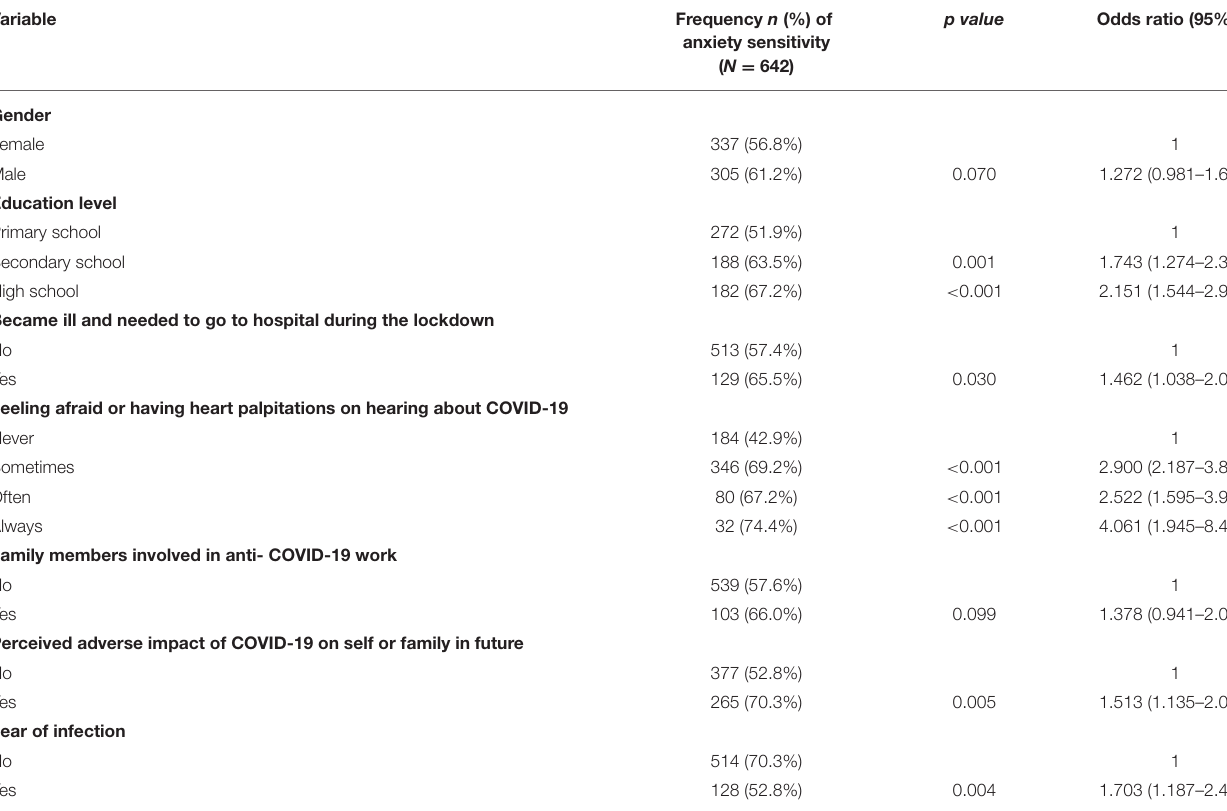
TABLE 5 | Factors related to anxiety sensitivity in children and adolescents during the COVID-19 lockdown.